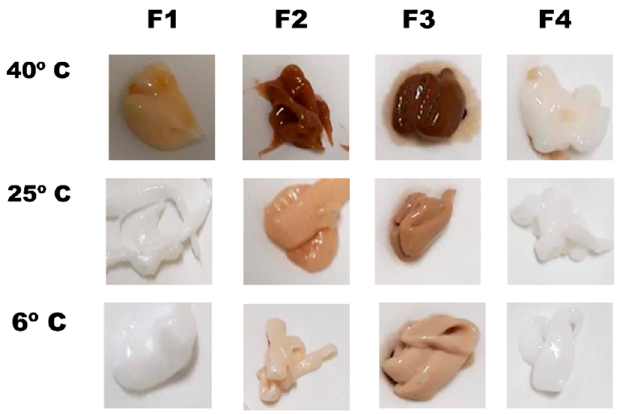
Figure 3. Chromatic aberrations on formulations stores during 30 days at di ff erent temperatures.